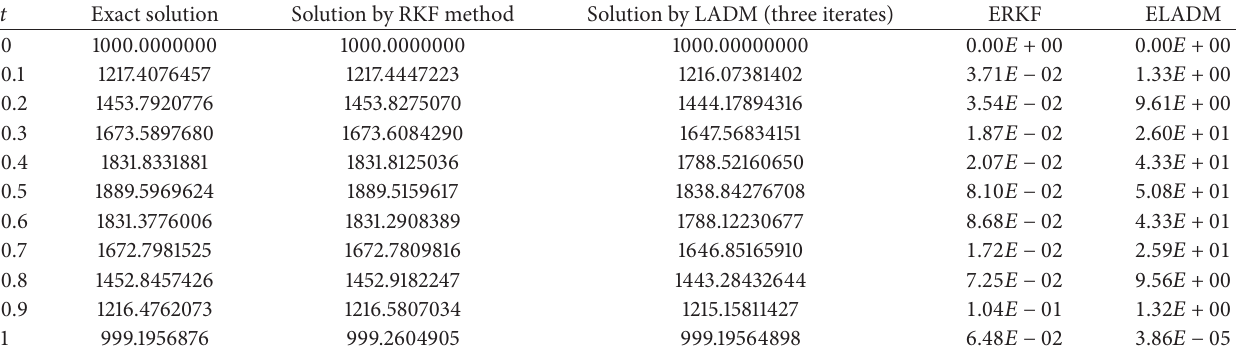
Figure 5: Evaluation between the exact solution and the solutions obtained by using LADM and RKF method for model V. Table 1: Numerical comparison when initial condition is 𝑃(0) = 1000 and 𝐾 = 2 , 𝜆 = 𝜋 , ℎ = 0.1